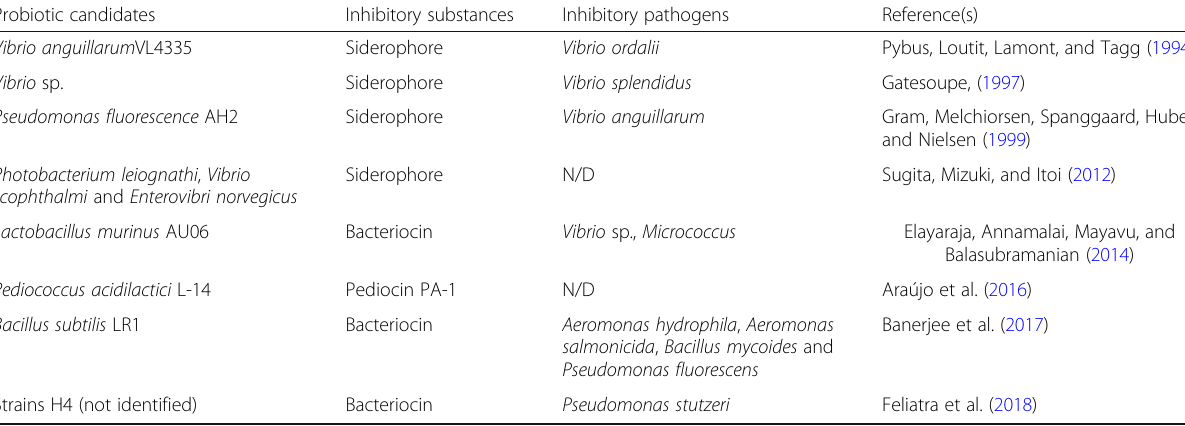
Table 5 Production of inhibitory substances by probiotic candidates Probiotic